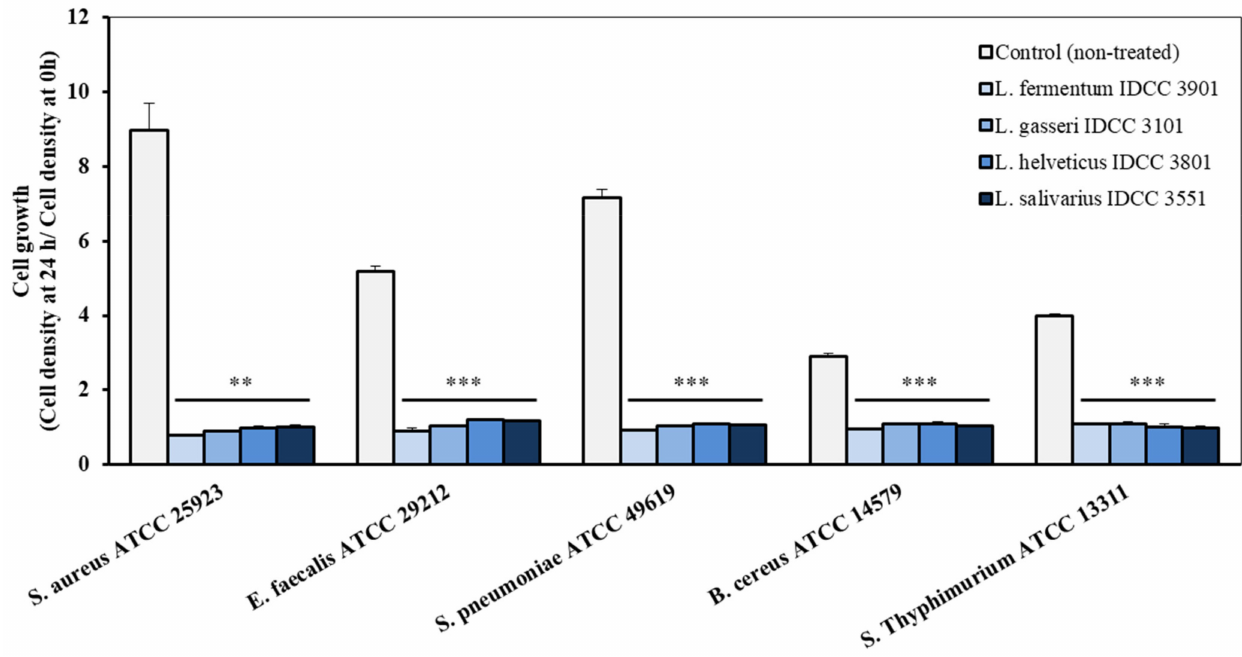
Figure 2. Antimicrobial effect of the cell-free supernatant of the four Lactobacillus strains on pathogenic microorganisms. (**, p < 0.01; ***, p < 0.001 vs. control